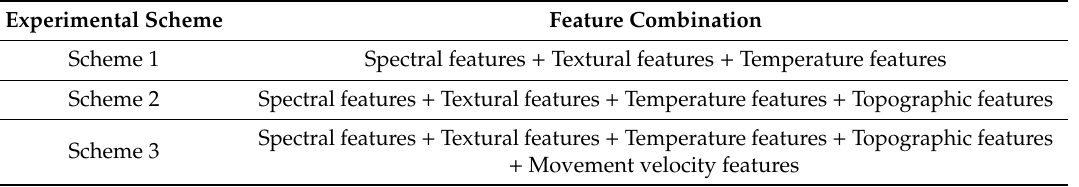
Table 4. Experimental Scheme Information.